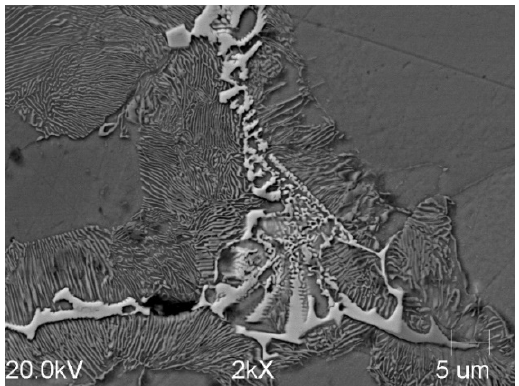
Figure 6. SEM microstructure of investigated ductile iron in intercellular region (g = 13 mm) with visible pearlite and carbides morphology.